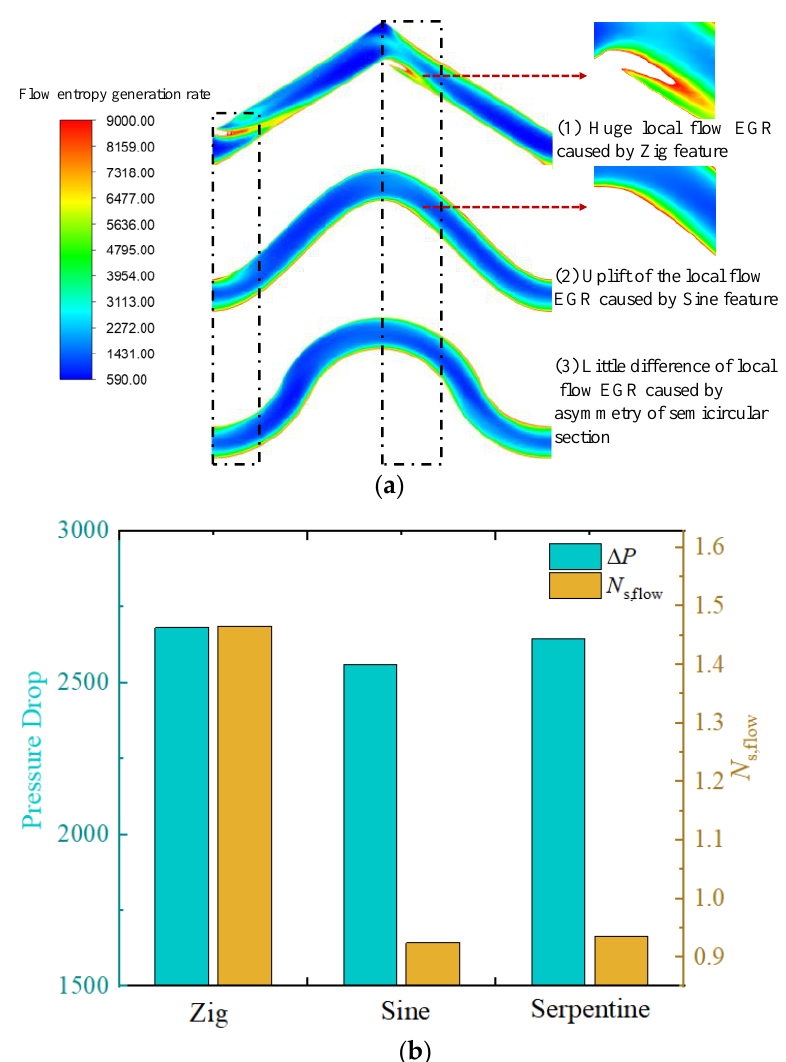
Figure 25. The features of the flow pattern. ( a ) The distribution of local flow entropy generation rate.